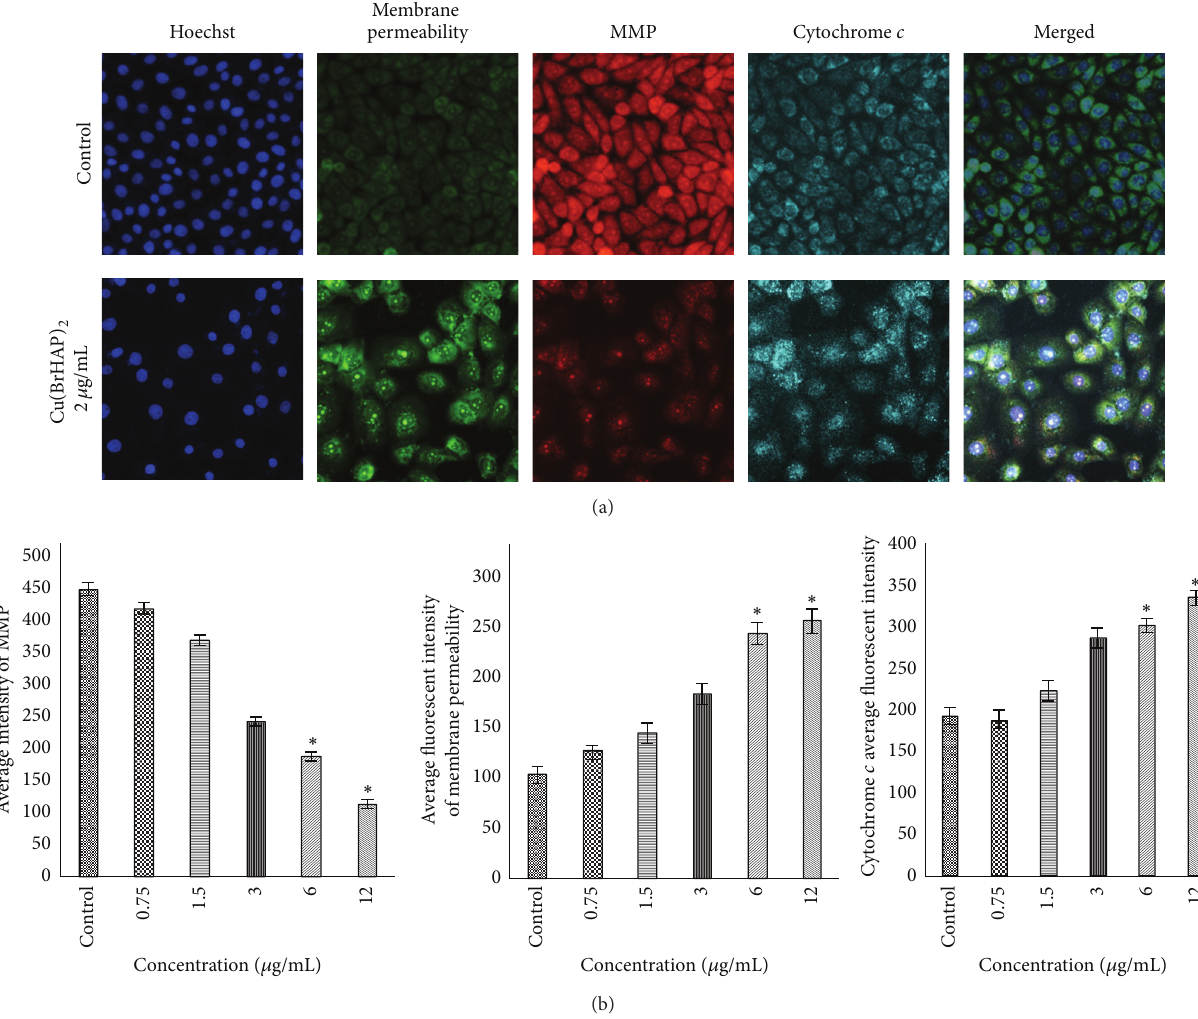
Figure 7: (a) Representative images of HT-29 cells treated with medium alone and 2 𝜇 g/mL of Cu(BrHAP) 2 and stained with Hoechst 33342 for nuclear, cytochrome c , membrane permeability, and mitochondrial membrane potential dyes. Cu(BrHAP) 2 induced a noteworthy elevation in membrane permeability and cytochrome 𝑐 release and a marked reduction in mitochondrial membrane potential (magnification: 200x). (b) Representative bar charts indicating dose-dependent increased cell permeability reduced MMP and increased cytochrome 𝑐 release in treated HT-29 cells.